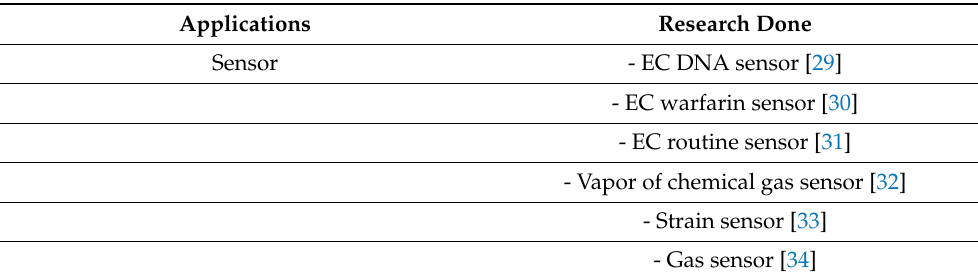
Table 2. Previous research conducted for CNTs-based polymer composites